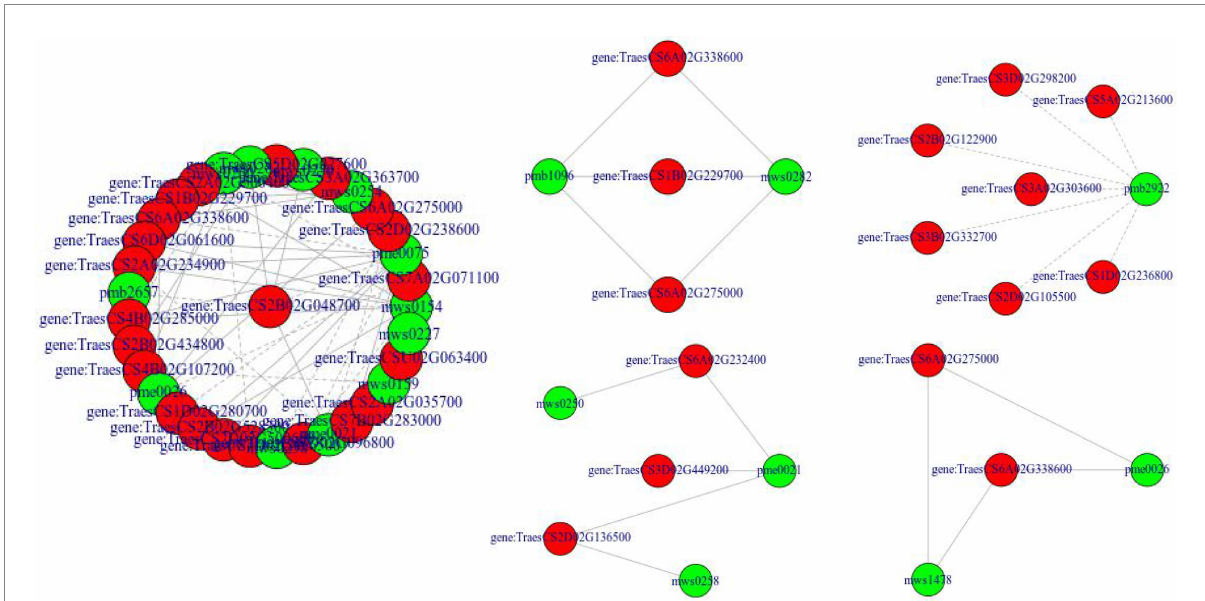
FIGURE 10 Network constructed based on the co-regulated pathways of metabolome and transcriptome. Red indicates genes, green indicates metabolites, solid line indicates positive relationship, and dash line indicates negative